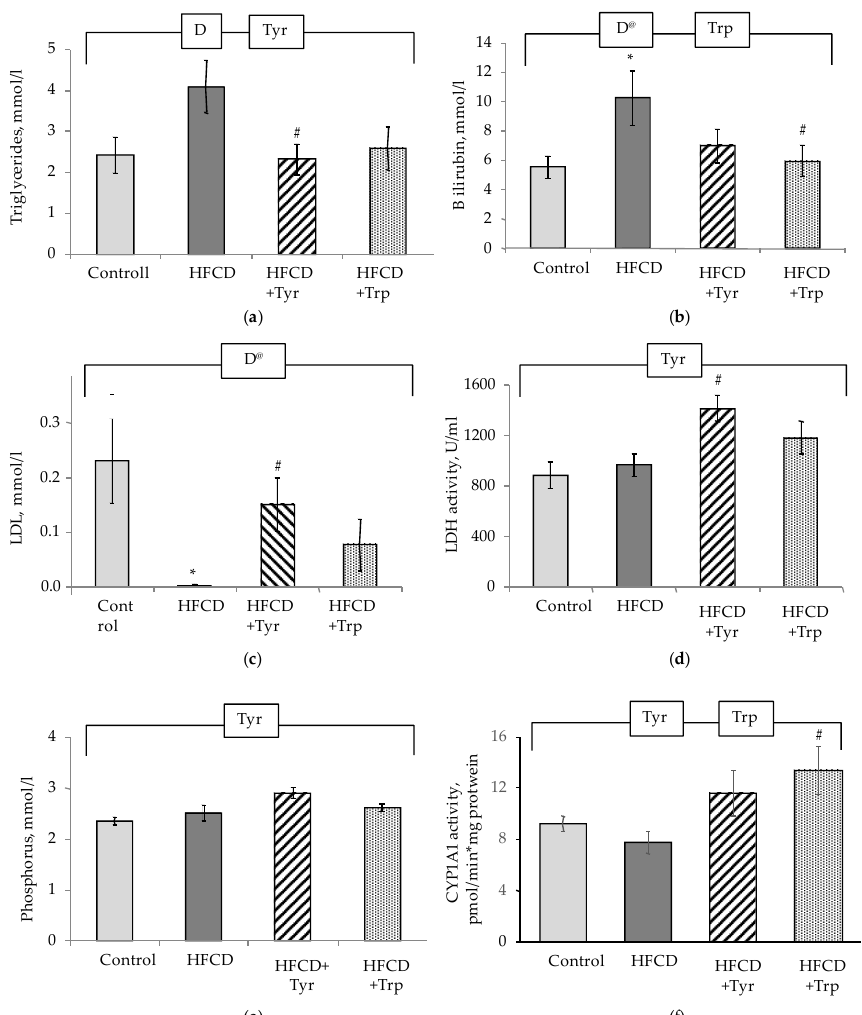
Figure 5. Biochemical parameters of blood plasma and liver of rats, mean ± standard error of the mean. Triglycerides ( a ), bilirubin ( b ), LDL cholesterol content (calculation) ( c ), LDH activity ( d ), phosphorus content ( e ), CYP1A1 activity in the microsomal fraction ( f ). *the difference with the control group is significant; # the difference with the group receiving HFCD is significant, p < 0.05, Mann-Whitney test. The bracket above the bars denotes significant dependence on the factors: “diet” (D), “tyrosine” (Tyr), “tryptophan” (Trp), p < 0.05, 3-way ANOVA. Index @ excluding rats treated with Tyr. The numbers of animals in the groups were 8.